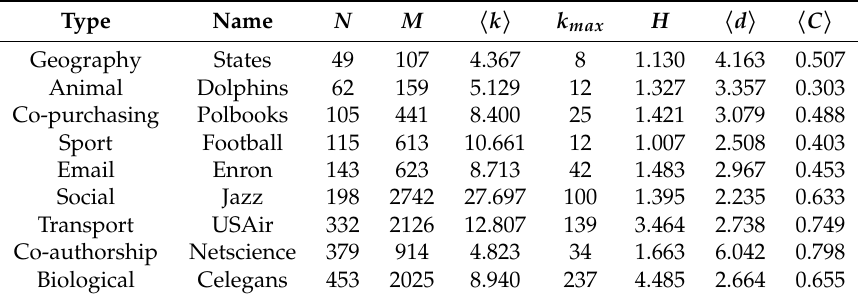
Figure 6. Source localization performance of different methods on synthetic networks with average degree (cid:104) k (cid:105) = 4 and signal-to-noise ratio µ / σ = 3. Table 3. Basic topological features of nine real networks. N and M are the numbers of nodes and edges. (cid:104) k (cid:105) and k max are the average degree and the maximum degree. H is the degree heterogeneity. (cid:104) d (cid:105) denotes the average path length between nodes pair. (cid:104) C (cid:105) is the average local clustering coefficient of the